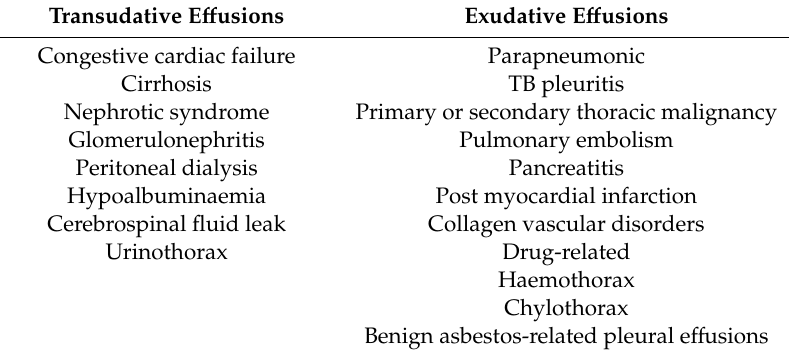
Table 1. Causes of pleural e ff usions [10].